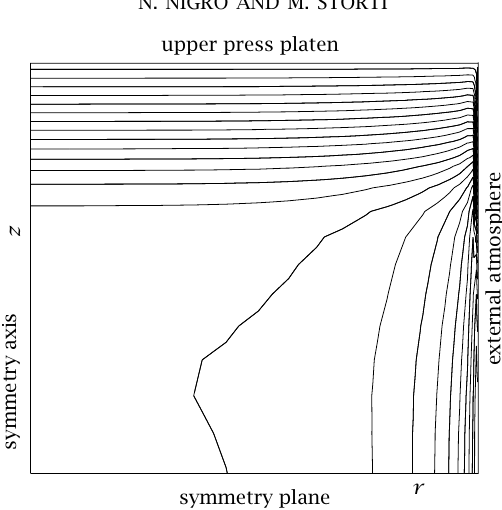
Figure 5.9 . Isotherms at t = 200s ( z and r axis not to scale).